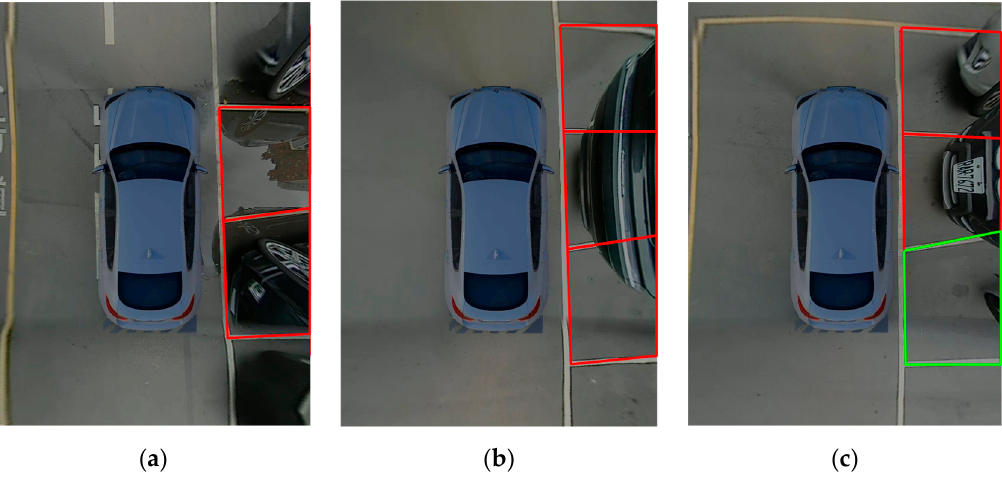
Figure 27. Examples of space occupancy classification failures. ( a ) Puddle; ( b ) Car distortion; ( c ) Motorcycle.